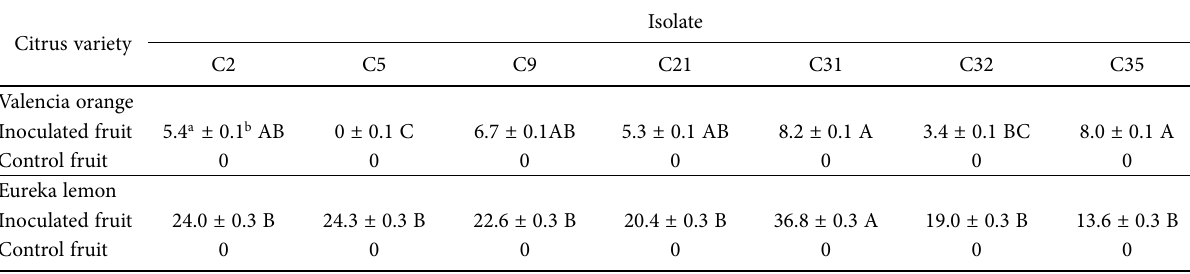
Table 3. Mean lesion diameter caused by Colletotrichum isolates on Valencia sweet orange and Eureka lemon.